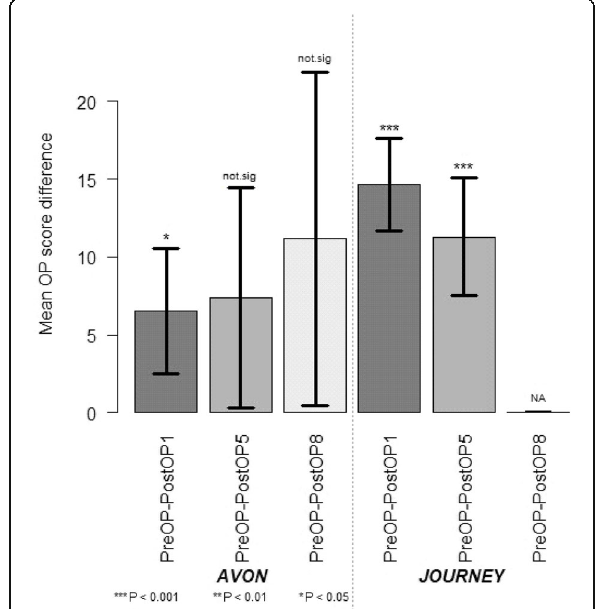
Fig. 3 Mean OKS difference at 1,5 and 8 year(s) after operation between two main different